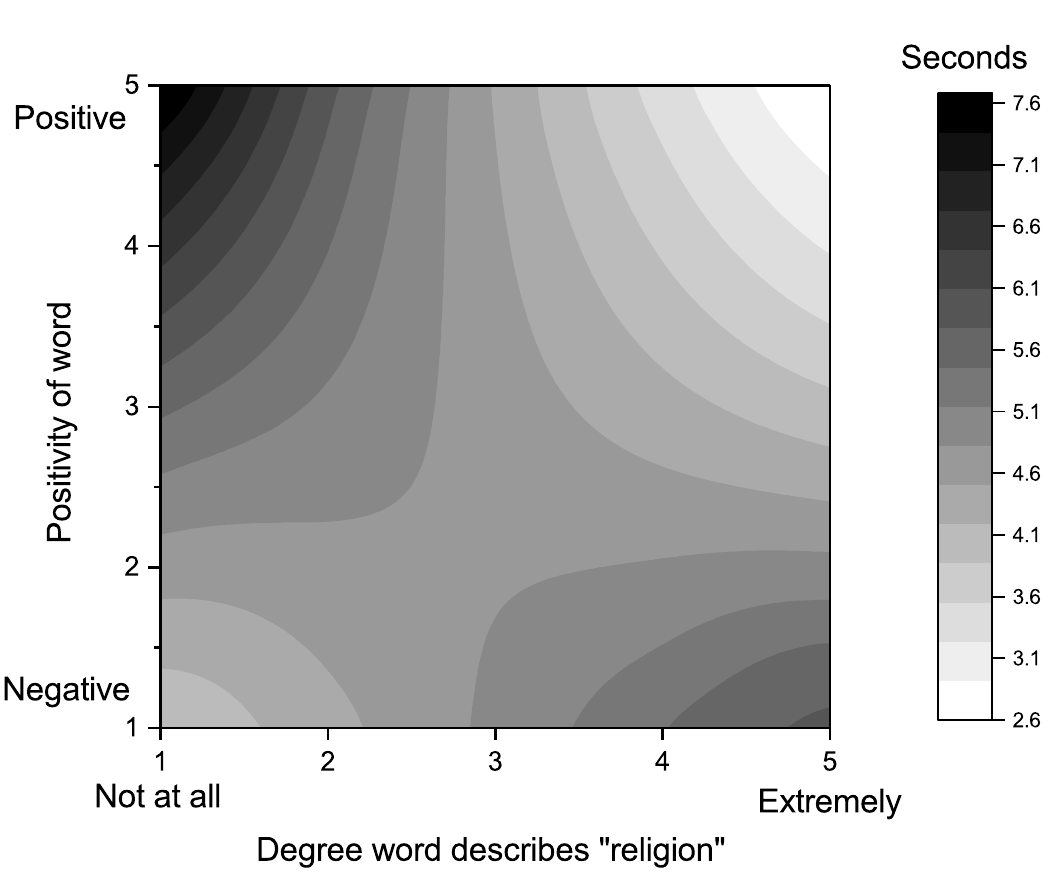
Figure 5: Raters: evangelicals; target: religion; predicted response latency